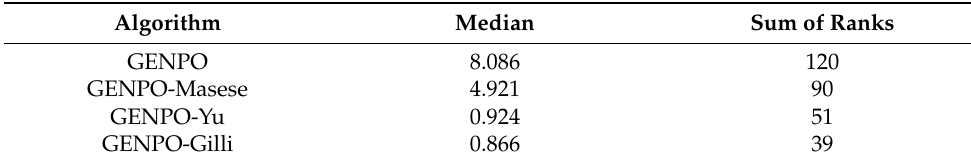
Table 9. Friedman Test Genetics Algorithms with MARR constraint.